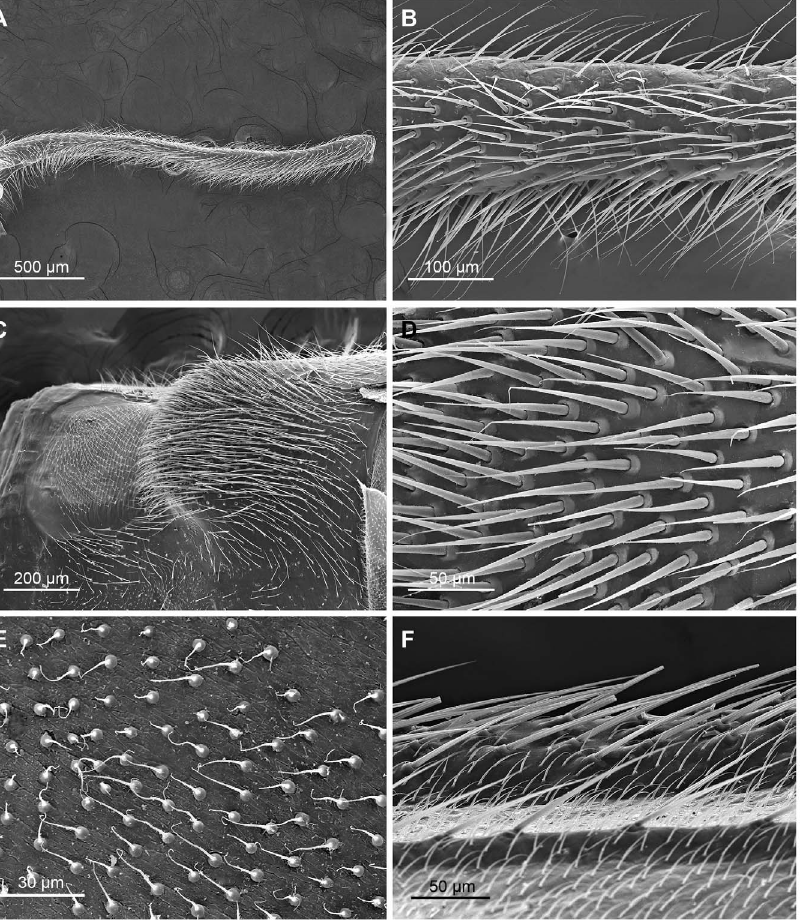
Figure 3. The notal organ and postnotal process of the male and the wing surface of the female in N.longiprocessa . (A) Notal organ, lateral view. (B) Magnification of the notal organ in lateral view, showing the setae. (C) Postnotal process, laterodorsal view. (D) Magnification of the postnotal process, showing the setae. (E) Magnification of the dorsal surface of the anterior half of the 4th tergum. (F) Upper surface of the female